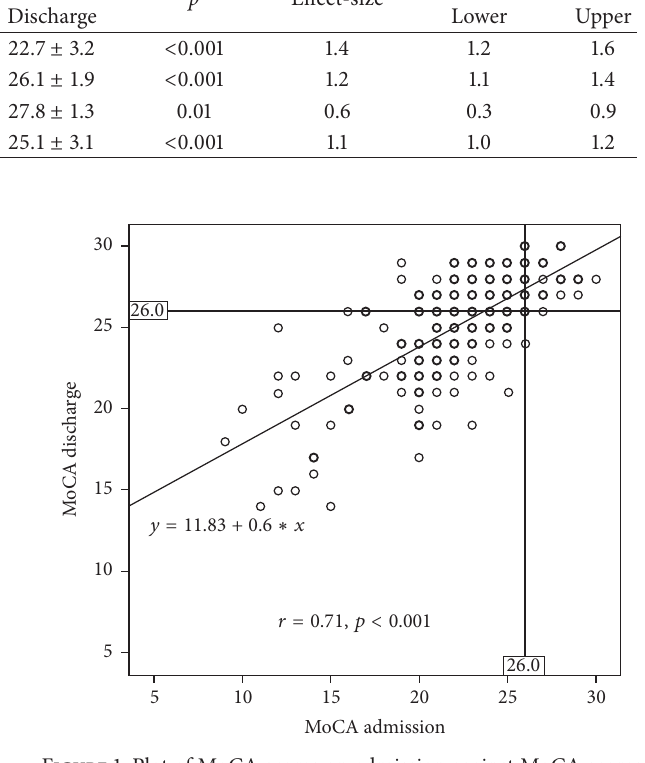
was 𝑦 = 11.83 + 0.6𝑥 (Figure